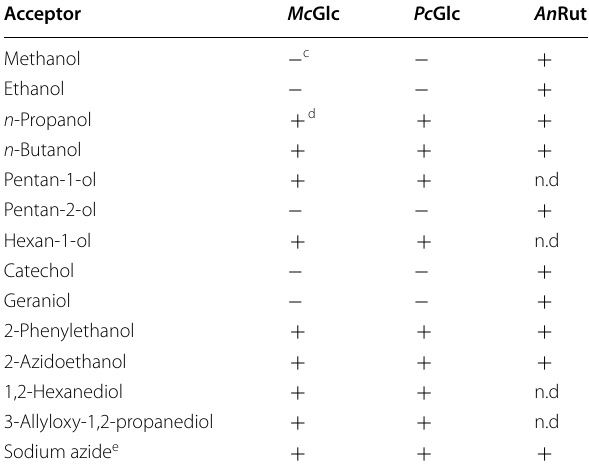
Table 2 Acceptor specificities for transglycosylation reactions with 2 as rutinosyl donor using Mc Glc or Pc Glc a as a catalyst— comparison with An Rut b